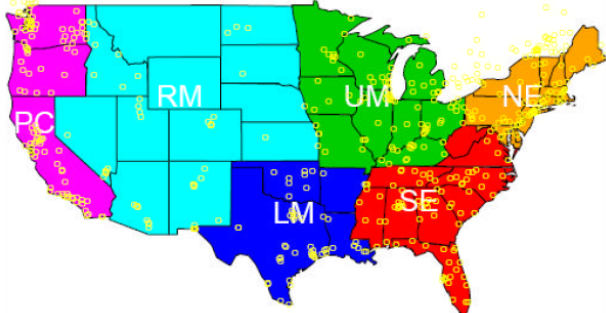
Fig. 1. Analysis sub-regions and monitoring sites (AIRnow network); the horizontal domain is discretized with a 442x265 12km grid cells. NE: Northeast, SE: southeast, UM: Upper Midwest, LM: Lower Midwest, RM: Rocky Mountains, PC: Pacific Coast